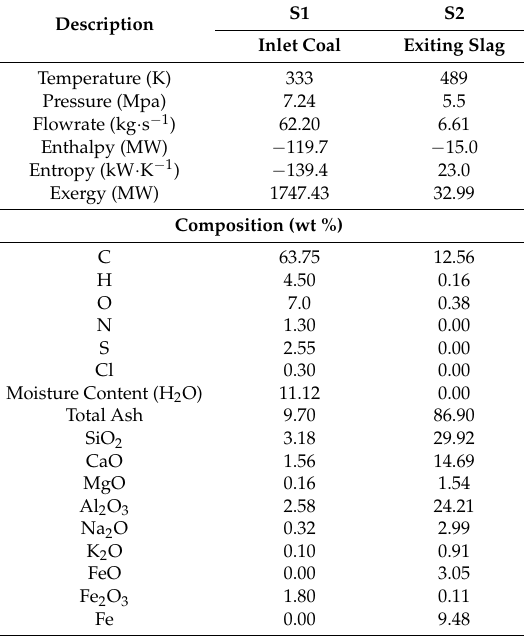
Table 3. Composition of solid